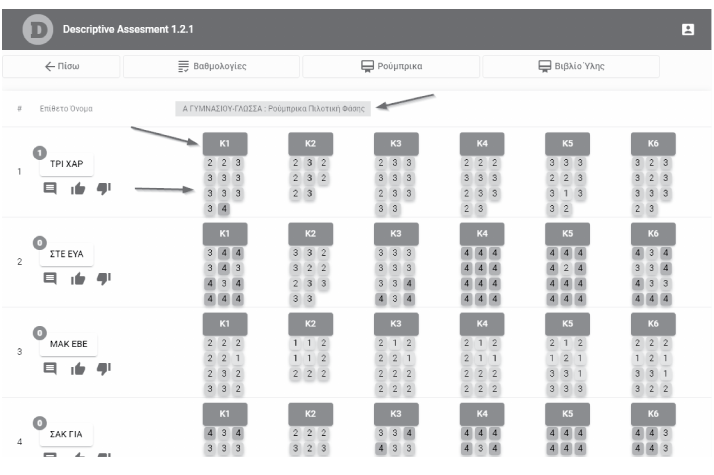
Figure 1. Assessment results (with and without graph).